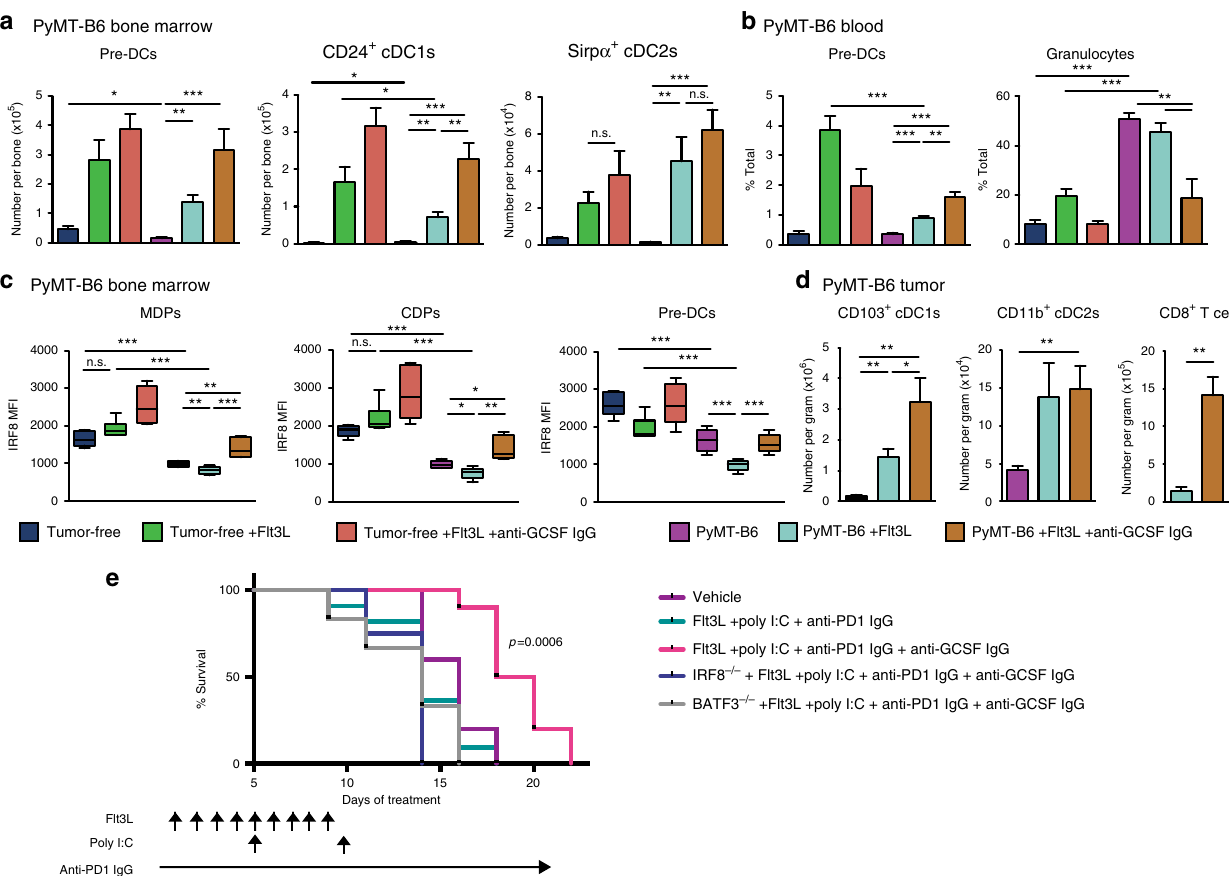
Fig. 9 GCSF neutralization synergizes with Flt3L in vivo to promote cDC1 numbers and function. Tumor-free mice or orthotopic PyMT-B6 tumor-bearing end-stage mice treated with 50 μ g anti-GCSF IgGs 3 × /week for 2 weeks and/or 30 μ g Flt3L daily for 9 days. End stage is de fi ned in the Methods. a Number of BM pre-DCs, CD24 + cDC1s, and Sirp α + cDC2s. b Number of blood pre-DCs and granulocytes. c IRF8 measured in BM MDPs, CDPs, and pre- DCs. d Number of tumor CD103 + cDC1s, CD11b + cDC2s, and CD8 + T cells (CD45 + CD3 + CD8 + ); n = 6/group. e Established 1 cm + diameter orthotopic PyMT-mCh-OVA mammary tumors were treated with vehicle or Flt3L (30 μ g) + anti-PD1 IgGs (200 μ g) + intratumoral Poly I:C (50 μ g) + / − anti-GCSF IgGs (50 ng) according to the displayed treatment schedule. Survival to 2.3 cm 3 tumor volume. Error bars represent mean + / − s.e.m.; * p < 0.05, ** p < 0.01, *** p < 0.001, n.s., not signi fi cant by unpaired two-sided Student ’ s t test. Log-rank (Mantel – Cox) p value is denoted for differences in